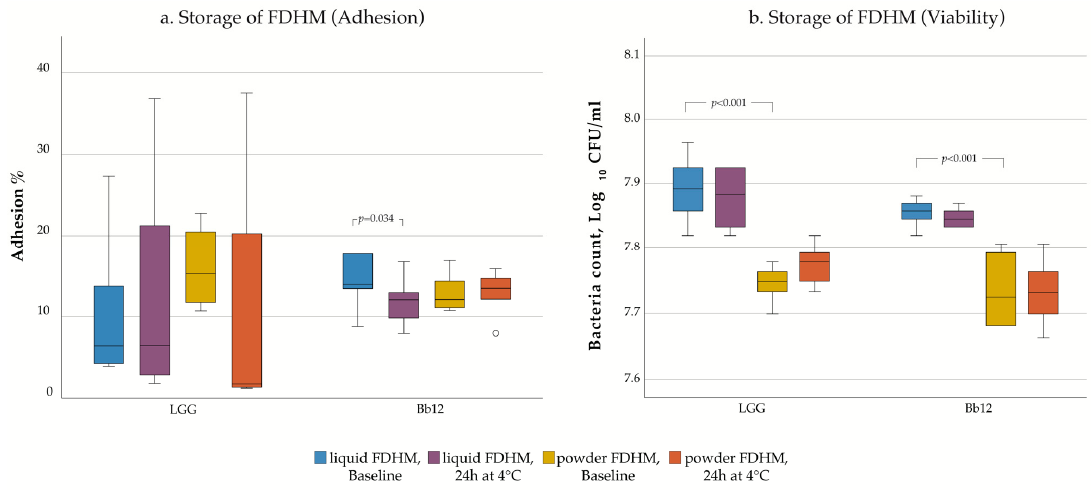
Figure 3. Mucus adhesion ( a ) and stability ( b ) of L. rhamnosus GG and B. lactis Bb12 in fortified donor human milk (FDHM) after storage at 4 °C for 24 h are presented with box plots. Outliers are marked with a circle (o).